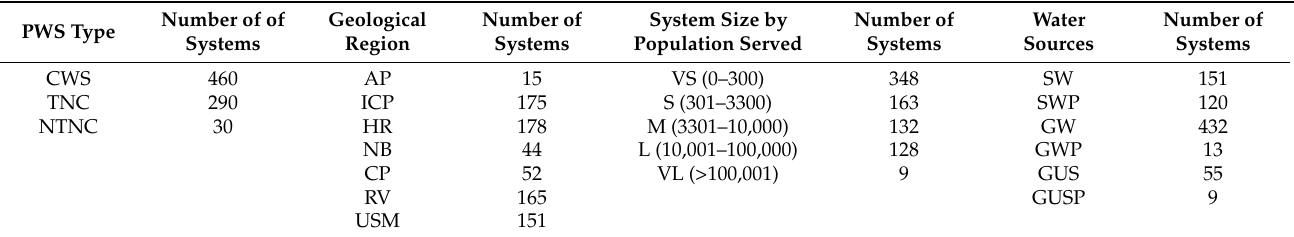
Table 1. Public Water System Characteristics and Geological